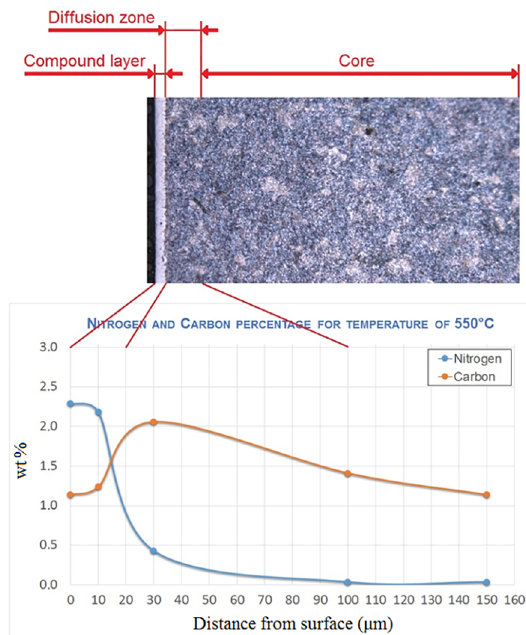
Figure 3. Chemical composition profiles for the samples nitrocarburized at 550°C.